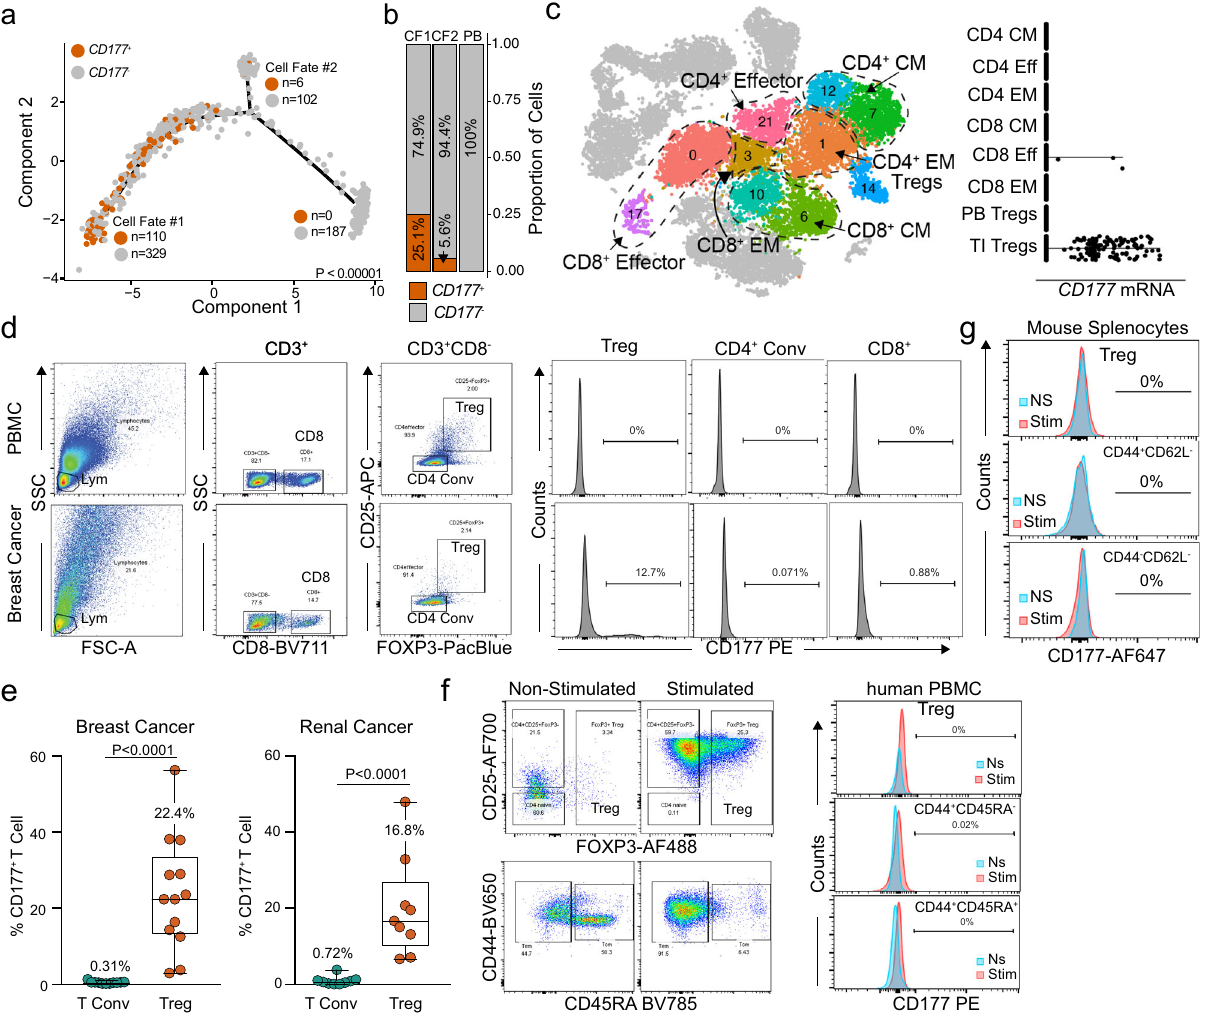
Fig. 4 CD177 is a marker for a subpopulation of TI Treg cells. a Trajectory manifold of Treg cells from the ccRCC TI Treg cells with the number of CD177 + and CD177 − Treg cells for each respective cell fate. The signi fi cance is based on χ 2 testing comparing the three poles of the manifold. b Proportional distribution of CD177 + Treg cells by cell fate across the manifold. c CD177 mRNA expression on different effector/memory T cell subpopulations within ccRCC dataset de fi ned by a gene signature including CD27 , CD28 , CCR7 , CCR5 , SELL and FAS . CM: central memory; Eff, effector; EM, effector memory. d Schematic fl ow cytometry data gating on lymphocytes (lym) were further analyzed for CD177 expression on Treg cells (CD4 + CD25 + FOXP3 + ), conventional CD4 T cells (CD4 conv, CD4 + CD25 − ) and CD8 T cells (CD8) isolated from TI lymphocytes in breast cancer or PBMC. e Percent CD177 + cells within TI CD4 Tconv or TI Treg cells in breast cancer ( n = 13, mean ± SD) and renal cancer ( n = 9, mean ± SD). Two-sided unpaired T-test was used. f CD177 protein expression on different T cell subpopulations de fi ned by CD44 and CD45RA from PBMC of breast cancer patients. Treg cells (CD4 + CD25 + CD127 low ) and CD4 conv cells (CD4 conv, CD4 + CD25 − ) were puri fi ed from human PBMC of breast cancer patients, either non-stimulated or stimulated (anti-CD3/CD28 + IL-2). Left: gating of Treg cells (top) or effector/memory population for CD4 Tconv (bottom); Right: CD177 expression on the gated populations. g CD177 protein expression on different effector/memory T cell subpopulations de fi ned by CD44 and CD62L from mouse spleens. Treg cells (CD4 + CD25 + GITR + ) and CD4 conv cells (Tconv, CD4 + CD25 − ) were puri fi ed from spleens of WT mouse, either non-stimulated or stimulated (anti-CD3/CD28 + IL-2). f , g CD177 expression was determined by fl ow